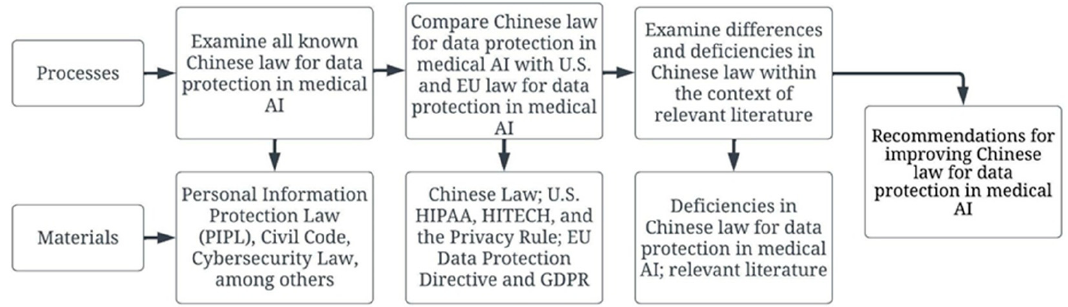
Figure 1. The processes and materials employed in the examination.